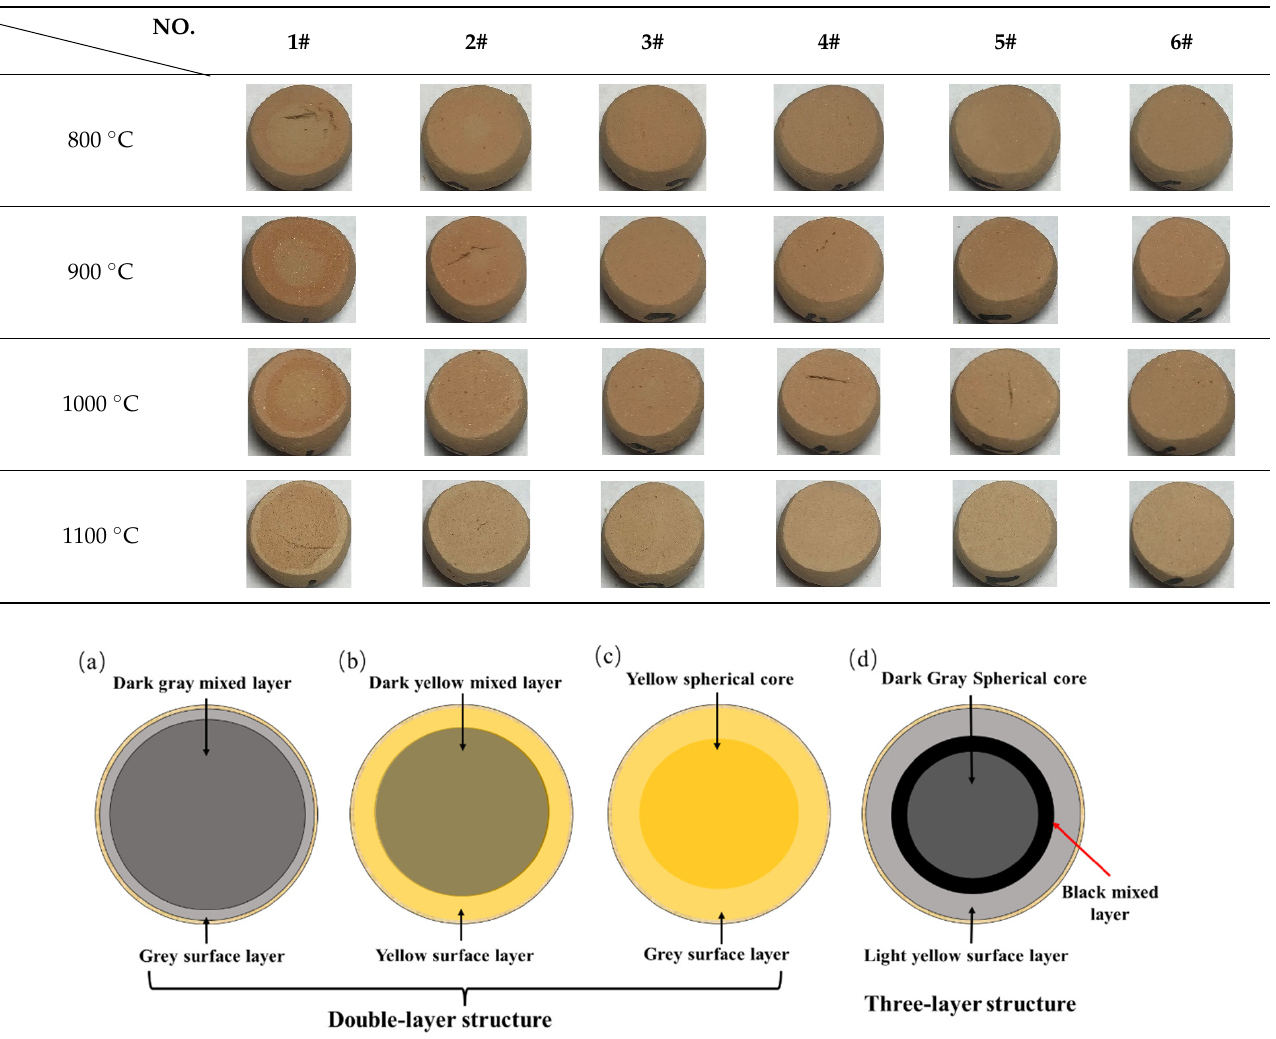
Figure 5. Schematic diagram of the internal structural changes of SS-C composite particles. ( a ) Gray surface layer-dark gray mixed layer, ( b ) yellow surface layer-dark yellow mixed layer, ( c ) light yellow surface layer-yellow spherical core, ( d ) gray surface layer-black mixed layer-dark gray spherical core. The change in color inside the SS-C composite particles is a macroscopic expression